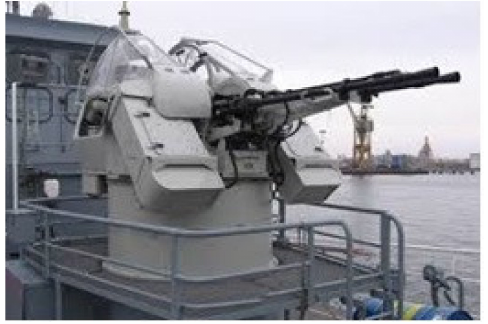
Figure 1. A general view of the artillery rocket set “Wr ó bel 2” mounted on the ship